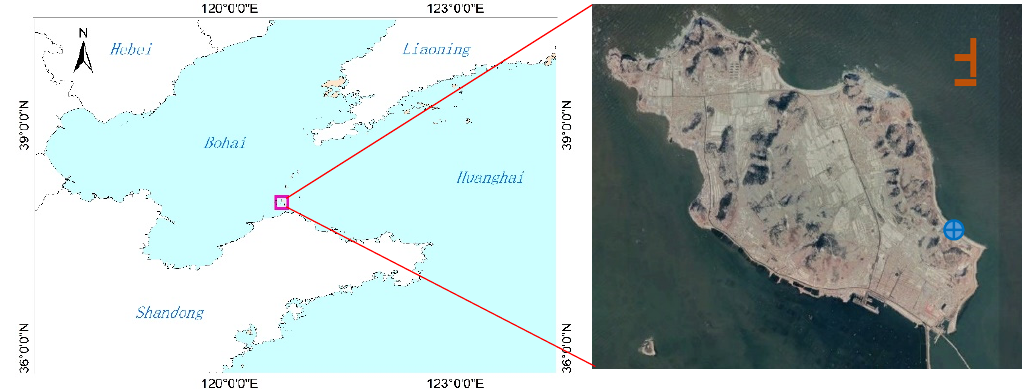
Figure 1. Landslide location of Beichangshan Island.